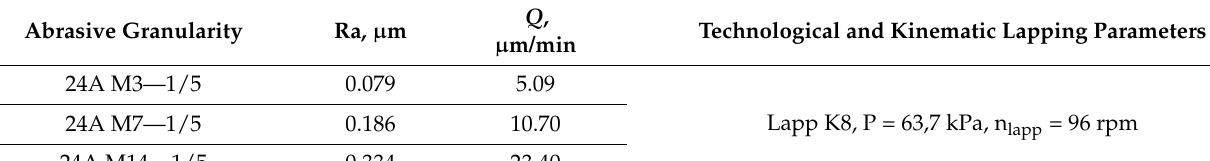
Figure 7. The lapp wear value as a result of real processing conditions.